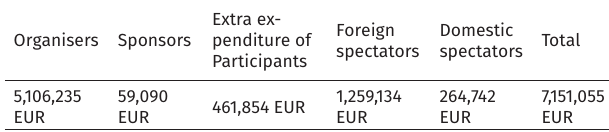
Table 2. Net direct expenditure by stakeholders in LIEBHERR 2019 WTTC (EUR) Extra ex- Organisers Sponsors penditure